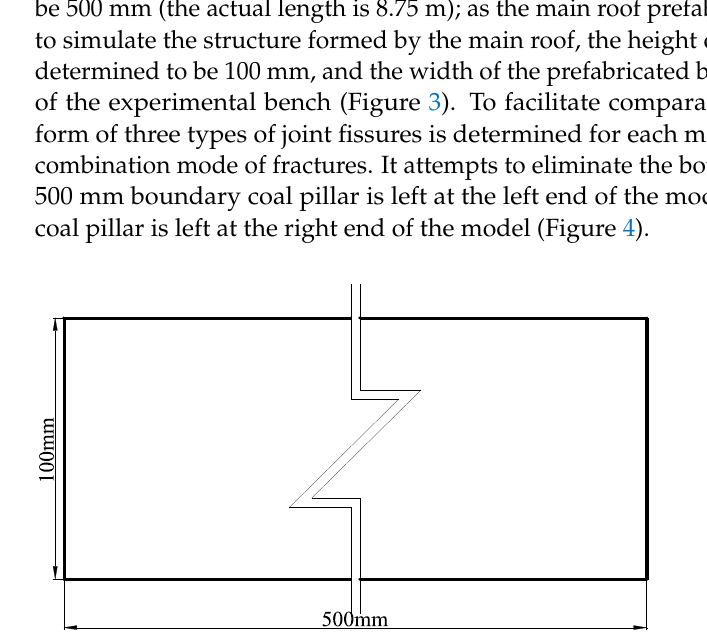
Table 3. Material ratio of physical model